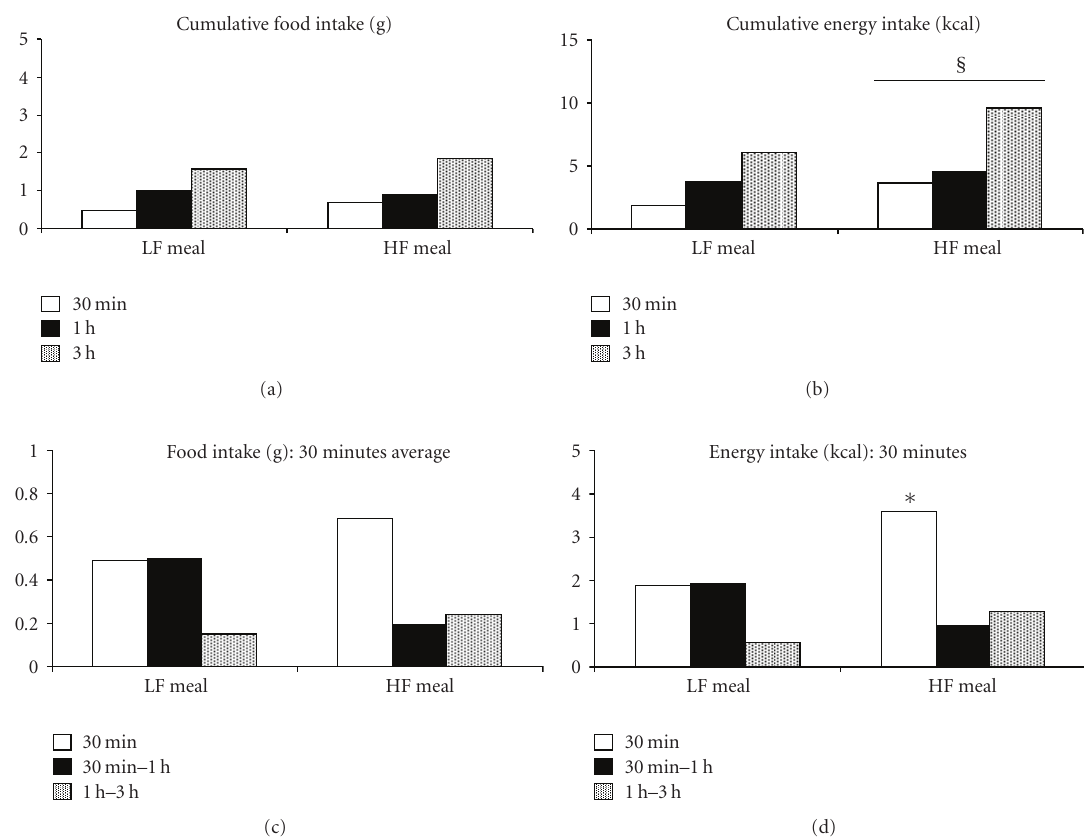
Figure 1: Food and energy intake of low-fat and high-fat meals: cumulative (a, b) and 30 minutes average (c, d) measurements. ∗ Significantly di ff erent compared to low-fat (LF) meal at the same time point ( P < . 05). § Significant e ff ect of the diet ( P < . 05). Abbreviations: g, grams; kcal, kilocalories; LF, low fat; HF, high